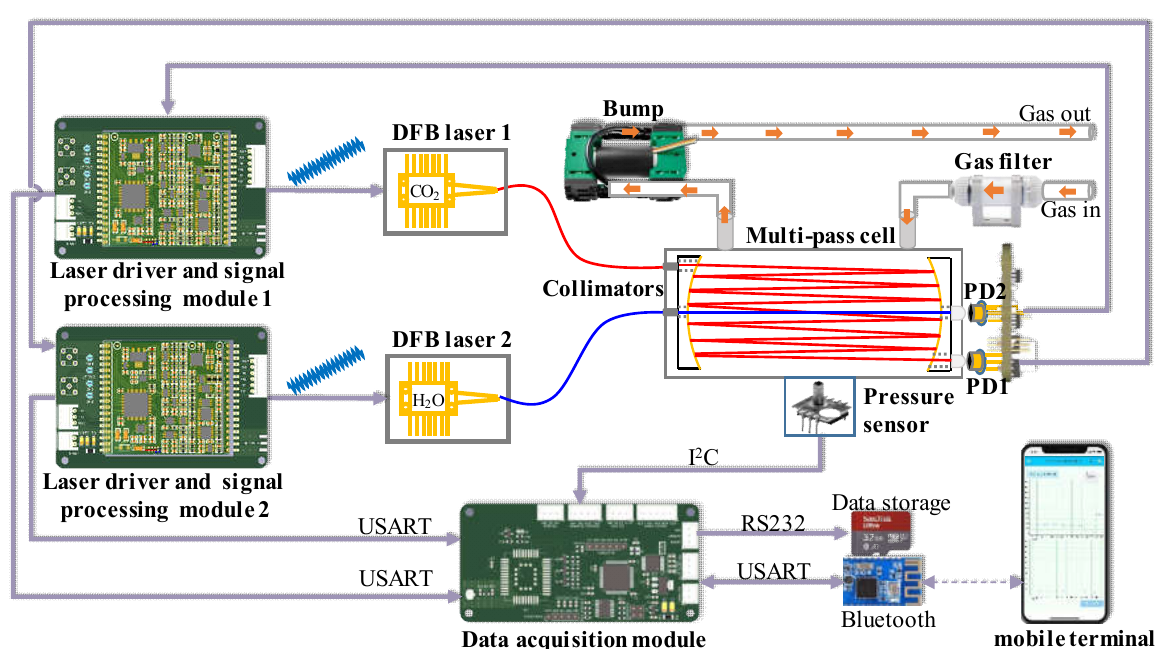
Figure 2. Schematic diagram of the TDLAS system for measuring atmospheric CO 2 and H 2 O con- centrations.